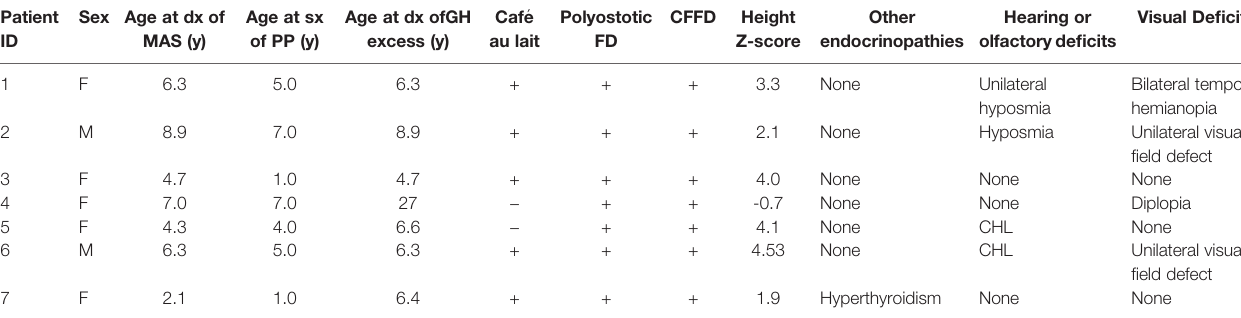
TABLE 1 | Demographic and clinical characteristics of PUMCH patients. Patient Sex Age at dx of ID MAS